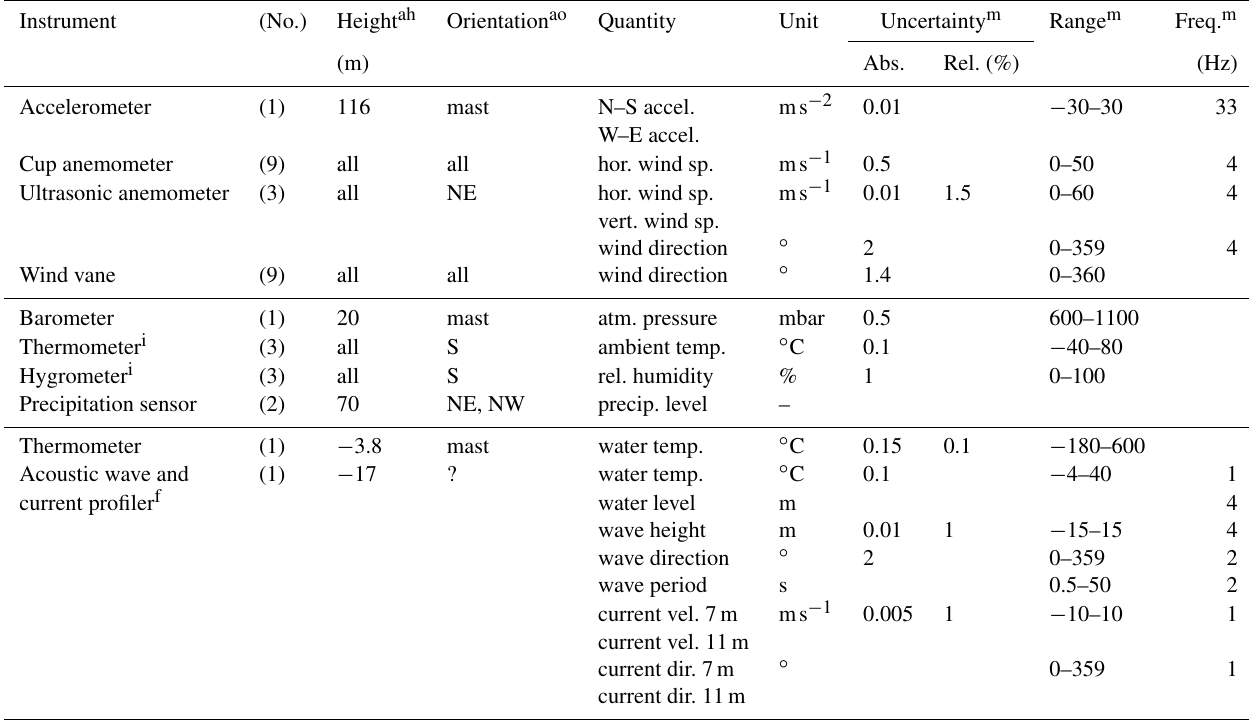
Table 1. An overview of the instruments and their locations on the OWEZ met mast (height in meters above mean sea level and boom orientation), the quantity measured, measurement uncertainty, the measurement ranges, and the sampling